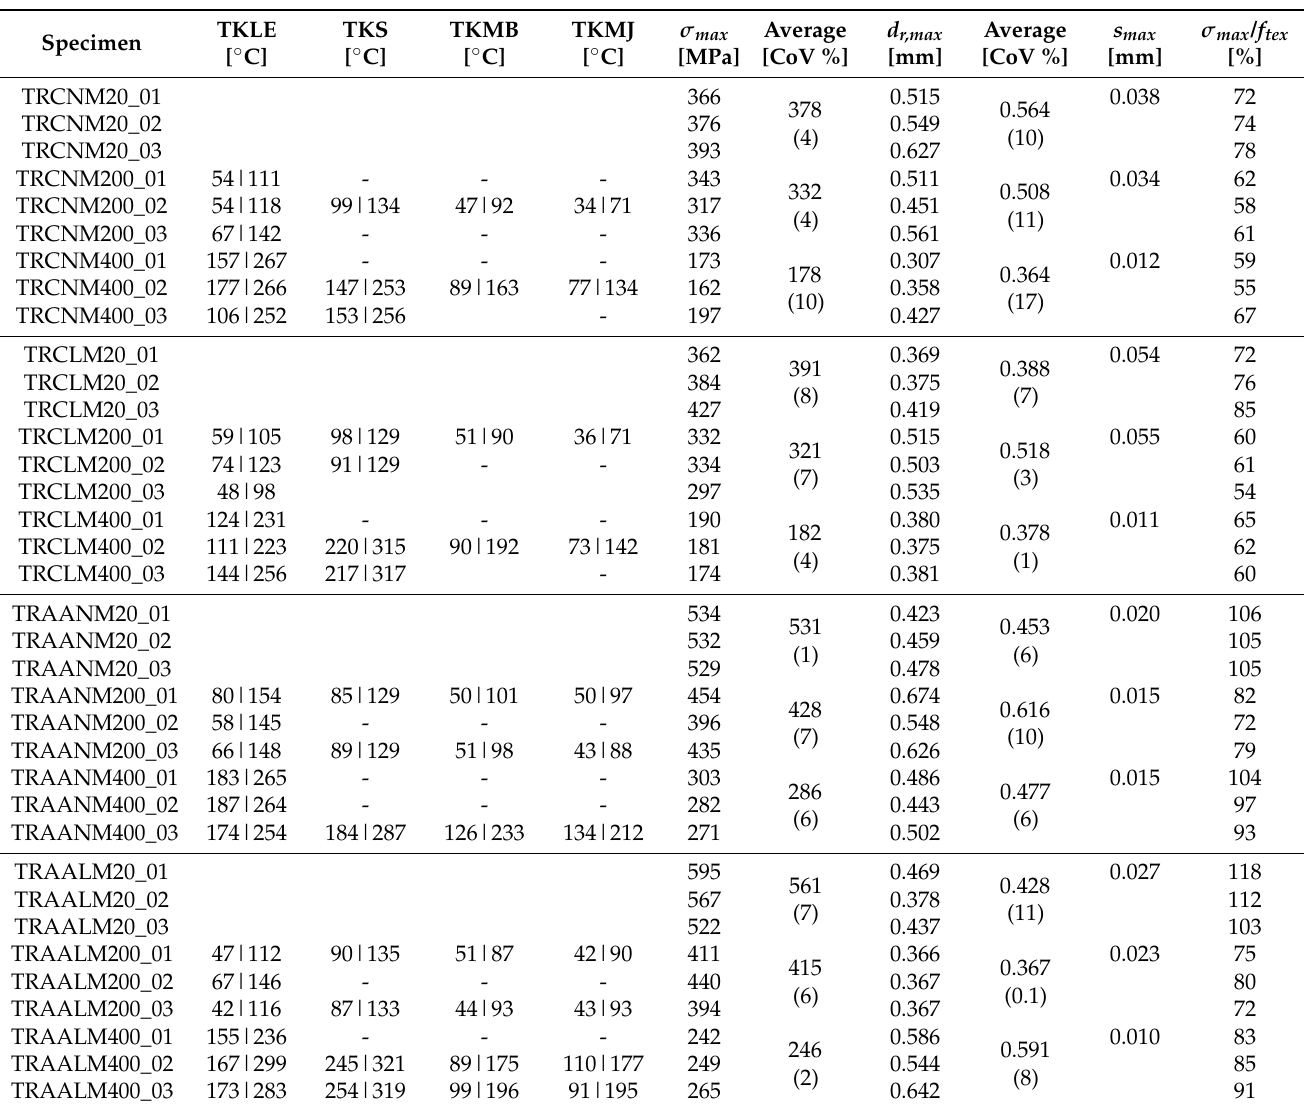
Table 3. Experimental results from the SL/SP